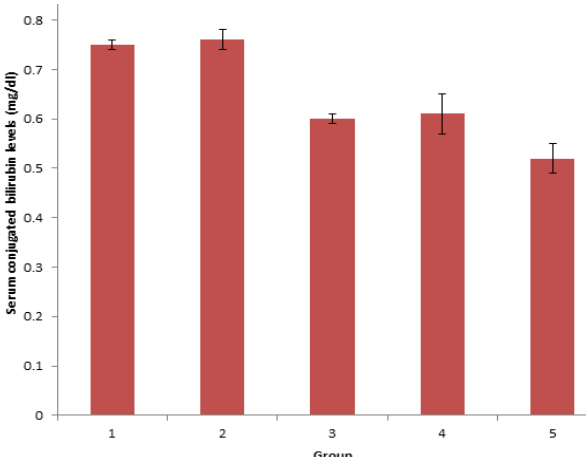
Fig. 2. Conjugated bilirubin values of alloxanized rats treated with varying concentrations of quail egg solution